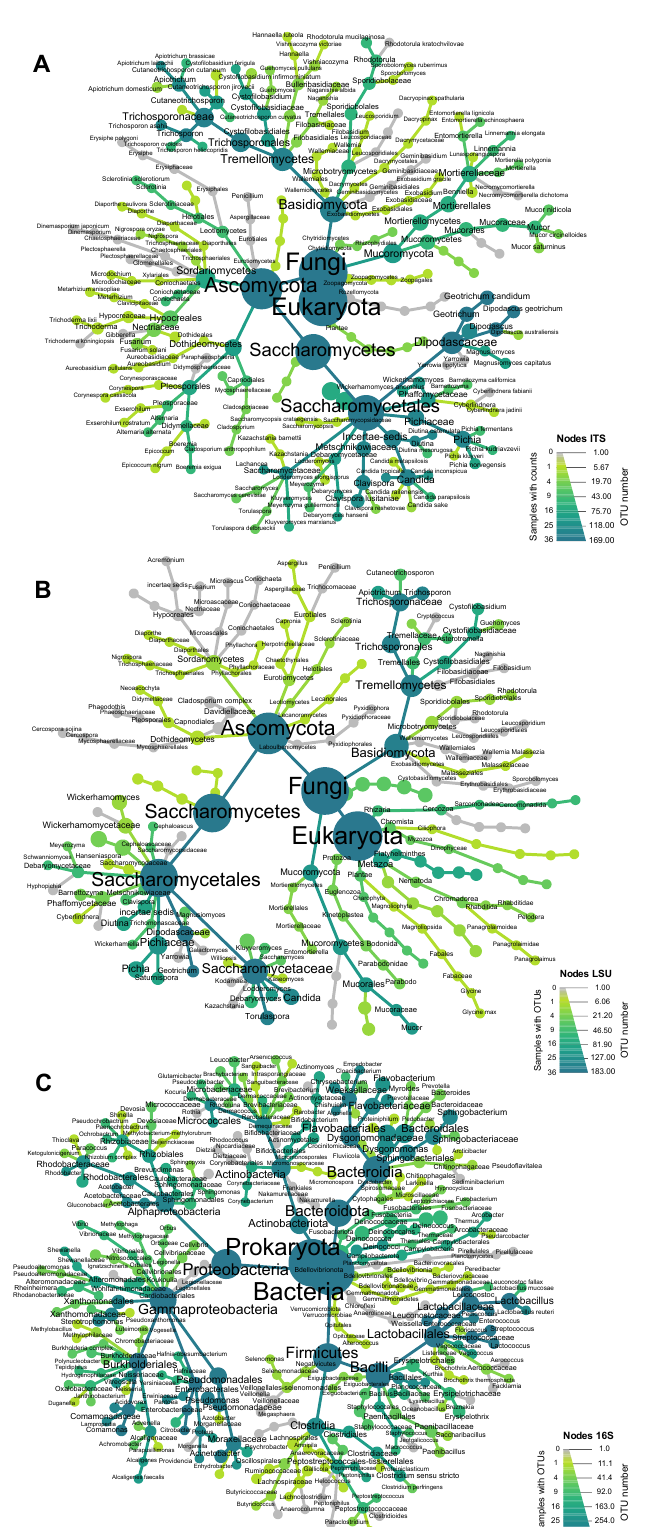
Figure 6. Heatmap abundance trees to visualize tofu microbial composition according the ( A ) ITS, the ( B ) LSU, and ( C ) 16S metagenomic marker datasets. The plot shows the number of samples from the inside niche (sampled from the inside of the tofu) that have counts (i.e., sequence reads) for each taxon as the color of each taxon. Core taxa have darker colors, while grey represents taxa that were absent in samples from the inside niche. The number of OTUs assigned to each taxon in the overall dataset is represented by the node